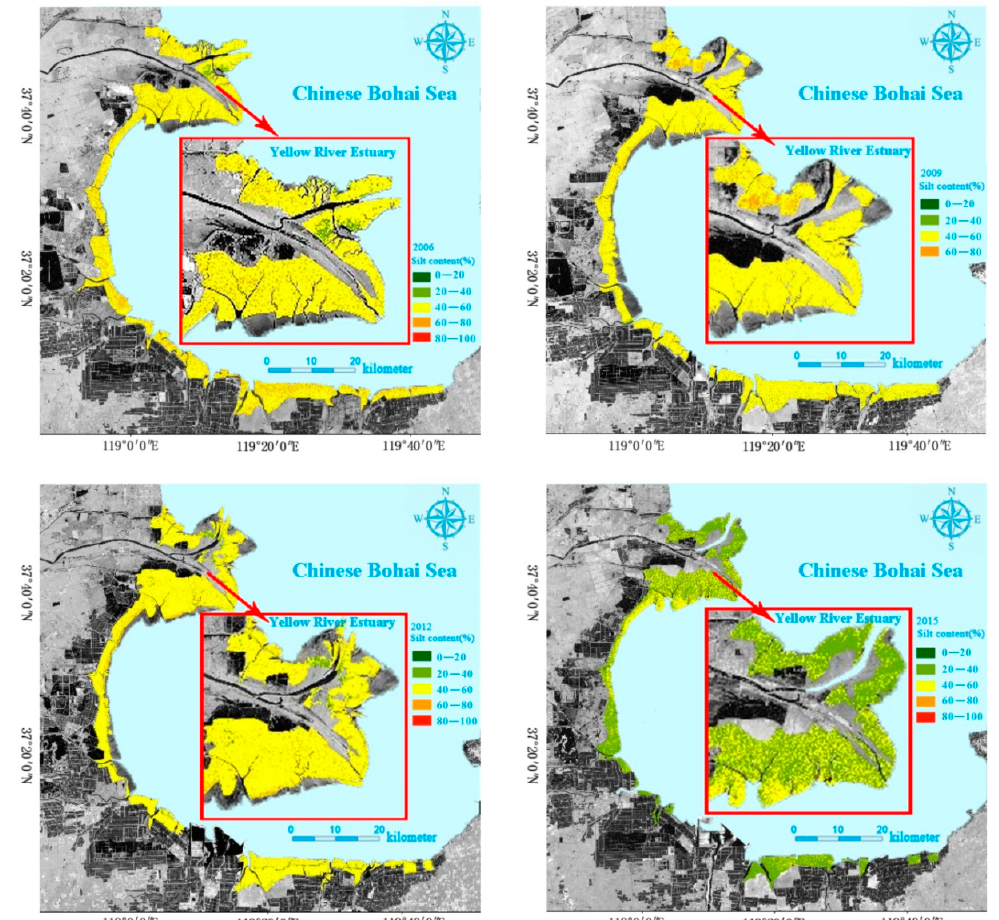
Figure 9. Spatial and temporal distribution of silt content from 1989 to 2015.